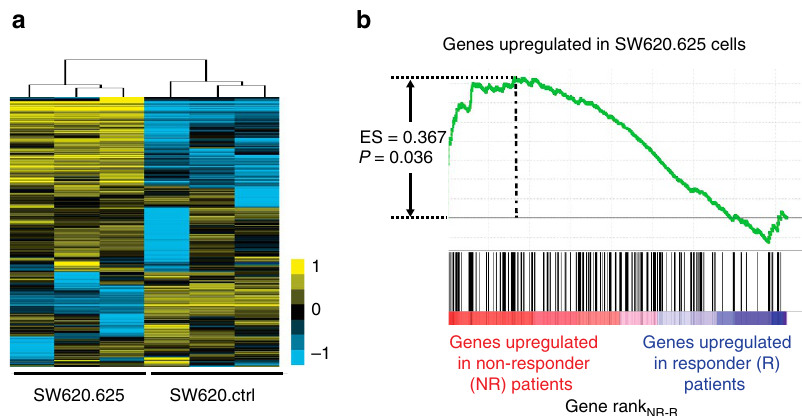
Figure 3 | miR-625-3p regulates networks associated with therapy response. ( a ) Unsupervised clustering of the most variable probe sets across three SW620.625 and three SW620.ctrl samples after DOX induction. ( b ) Expression profiles of primary tumours from first-line oxPt-treated mCRC patients were generated and 20,693 genes ranked according to difference in median expression between non-responder ( n ¼ 9) and responder ( n ¼ 17) patients. Genes upregulated in the SW620.625 cells (black vertical bars) were significantly associated with the non-responder phenotype (enrichment score ¼ 0.367, P ¼ 0.036, Kolmogorov–Smirnov